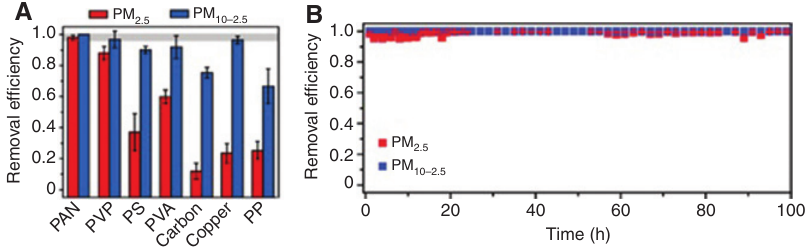
Figure 3: (A) Removal efficiency comparison between PAN, PVP, PS, PVA, PP carbon, and copper transparent filters with the same fiber diameter of ~ 200 nm and the same transmittance of ~ 70%. Error bar represents the standard deviation of three replicate measurements. (B) The long-term PM2.5 and PM10–2.5 removal efficiencies by PAN transparent filter of 70% transmittance under continuous hazardous level of PM pollution in a field test in Beijing. For details, see Ref. [23]; reprinted with permission from Nature Publishing